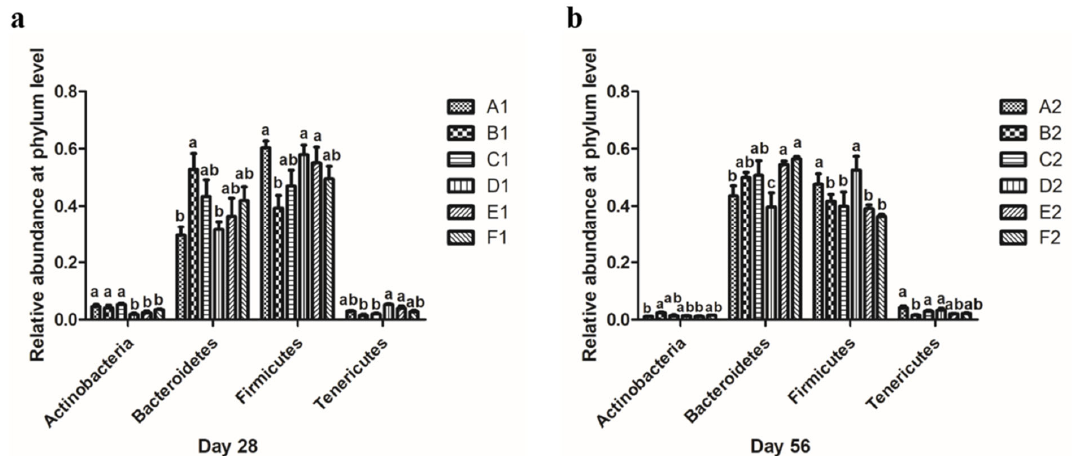
Figure 4. Effects of different additions of MOLP on the relative abundance of ( a ) the most dominant phylum ( ≥ 1%) on day 28 and ( b ) the most dominant phylum ( ≥ 1%) on day 56 in the cecum microflora of broiler chickens. The error bars represent the SEM of three samples, and the results are described as mean ± SEM. Statistical analysis of the data was performed by using Duncan’s method to analyze the significance of differences between samples by using IBM SPSS software. Means with similar superscripts in the same column indicate that there are no significant differences ( p > 0.05), and those with different superscripts in the same column indicate significant differences ( p < 0.05).